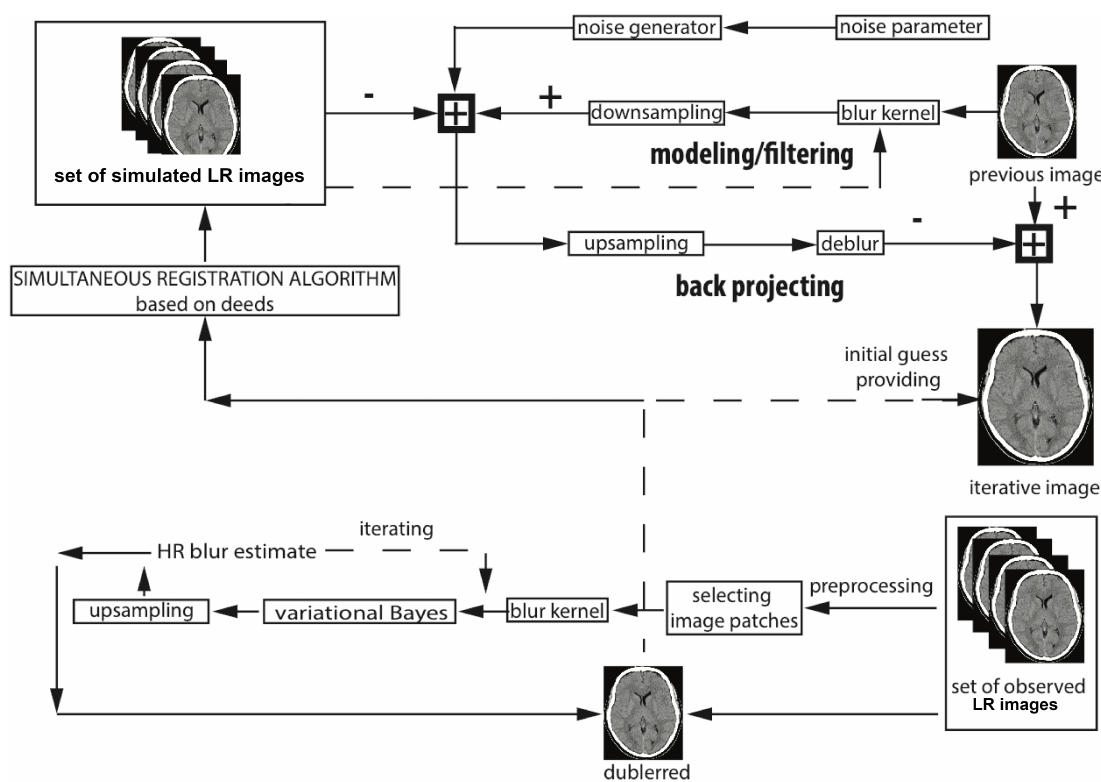
Figure 2. The proposed CT/PET image enhancement